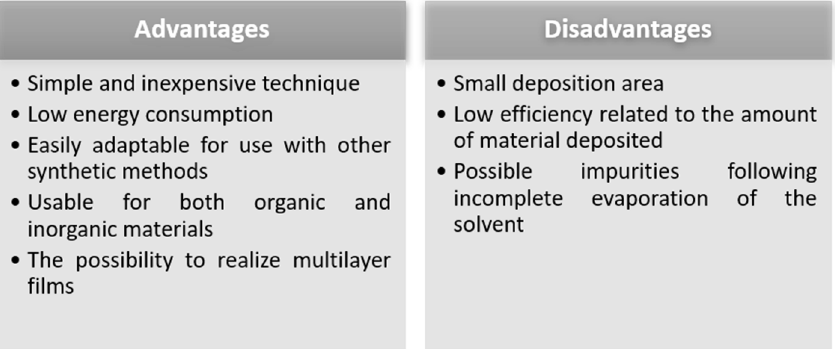
Figure 9. Advantages and disadvantages of the spin-coating deposition method.